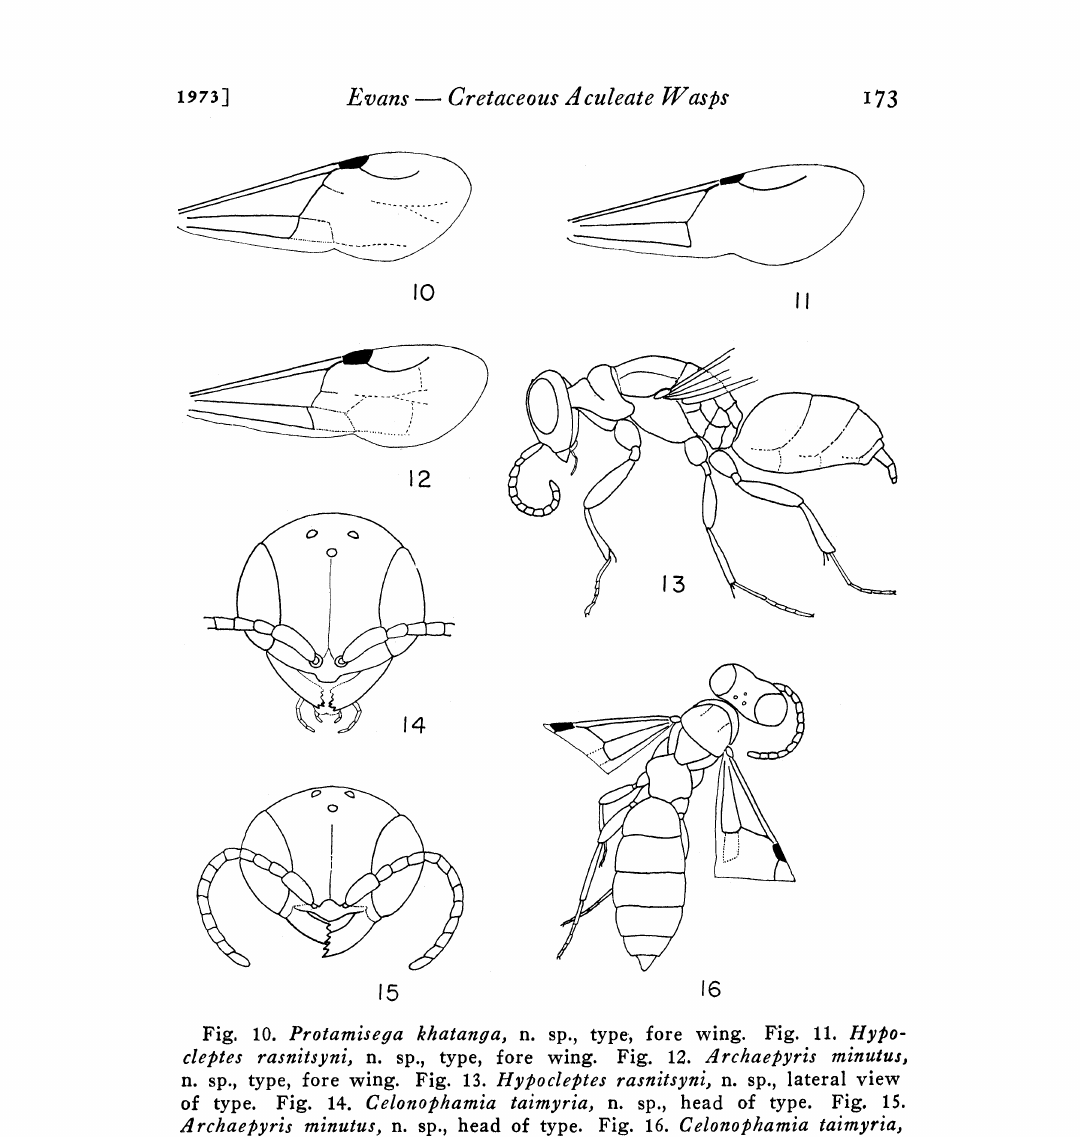
Fig. 10. ProtamiseTa khatanTa, n. sp., type., fore wing. Fig. 11. Hylo- cleptes rasnit’yni, n. sp., type, fore wing. Fig. 12../lrchae1yris minutus, n. sp., type, fore wing. Fig. 13. HylocleI)tes rasnitsyni, n. sp., lateral view of type. Fig. 14. Celonolhamia taimyria, n. sp., head of type. Fig. 15. ./lrchaeI)yris minutus, n. sp., head of type. Fig. 16. Celonothamia taimyria, n. sp., dorsal view of body and wings as preserved. Broadly dashed lines in Figures 10 and 12 indicate pale s,treaks in wing membrane, while finely stippled lines indicate weak